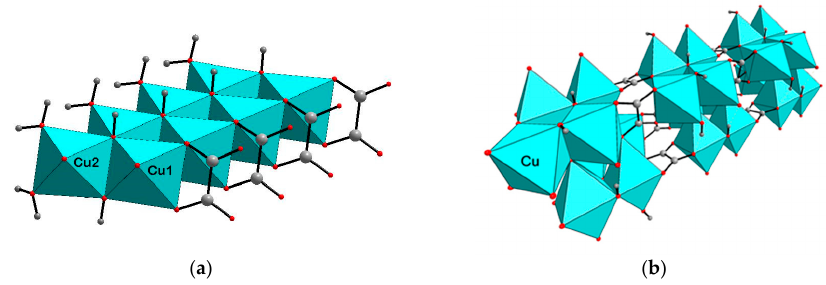
Figure 4. Portions of the polymeric rows observed in fiemmeite ( a ) and middlebackite ( b ).